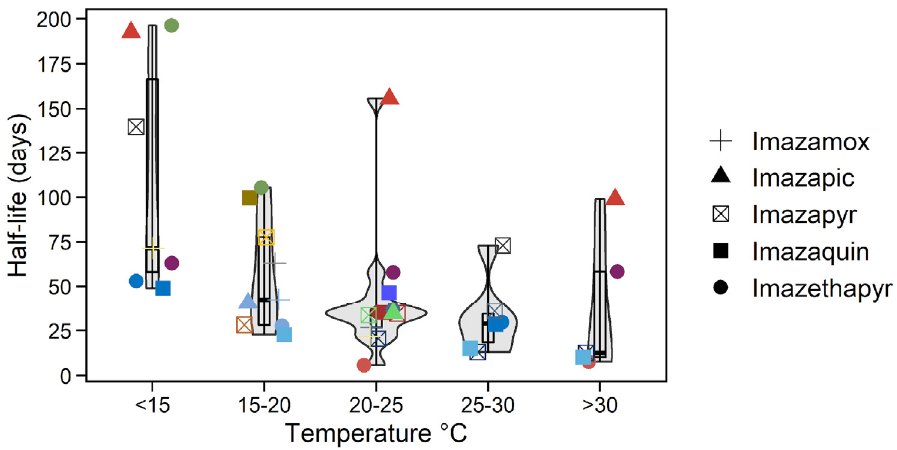
Figure 9. Effect of temperature on the half-life of imidazolinones (in days).